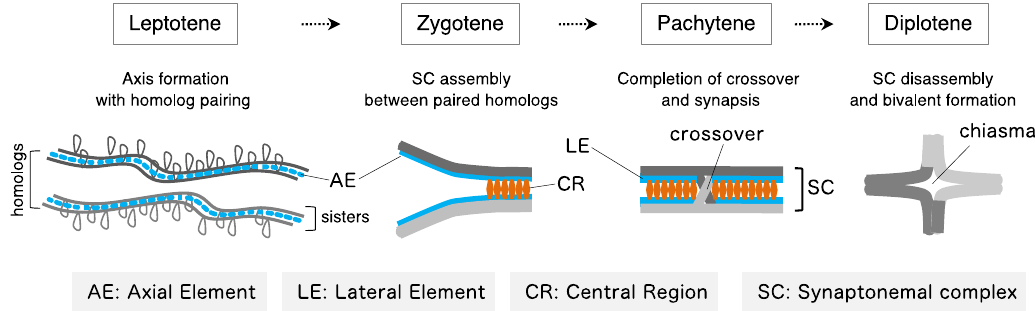
Figure 1. Chromosome segregation during mitosis and meiosis. Schematic diagram of chromosome segregation patterns during mitosis and meiosis. The picture shows spores of Schizosaccharomyces pombe produced after meiosis.